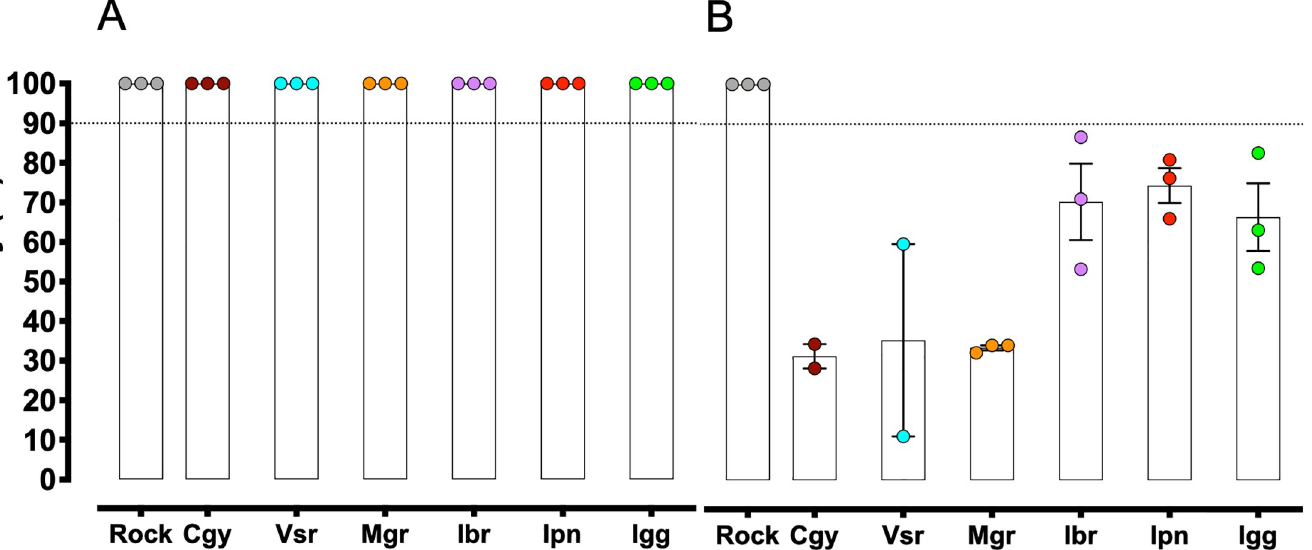
PLOS NeglectedTropical Diseases | https://doi.org/10.1371/journal.pntd.0008492 February 16,